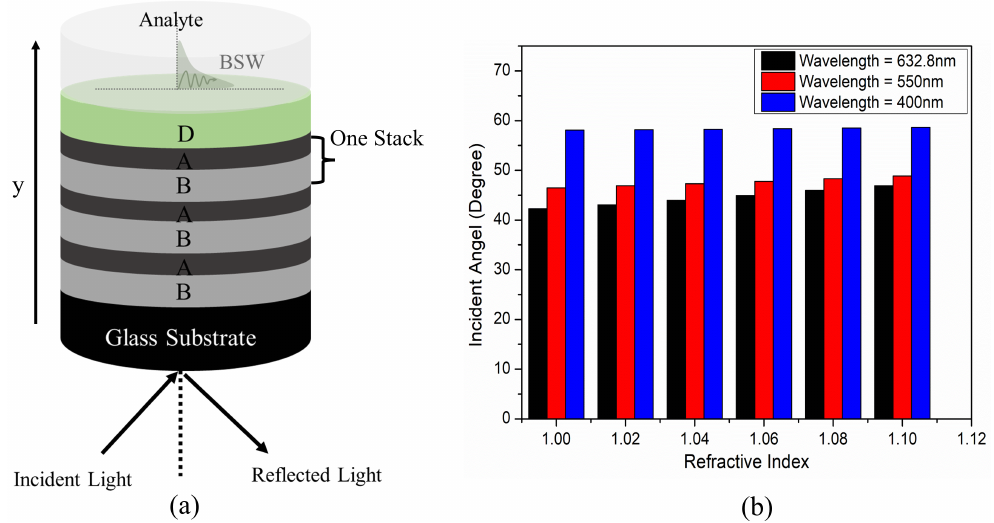
Figure 1. ( a ) Schematic representation of proposed devices, ( b ) Corresponding BSW excitation analysis at different incident